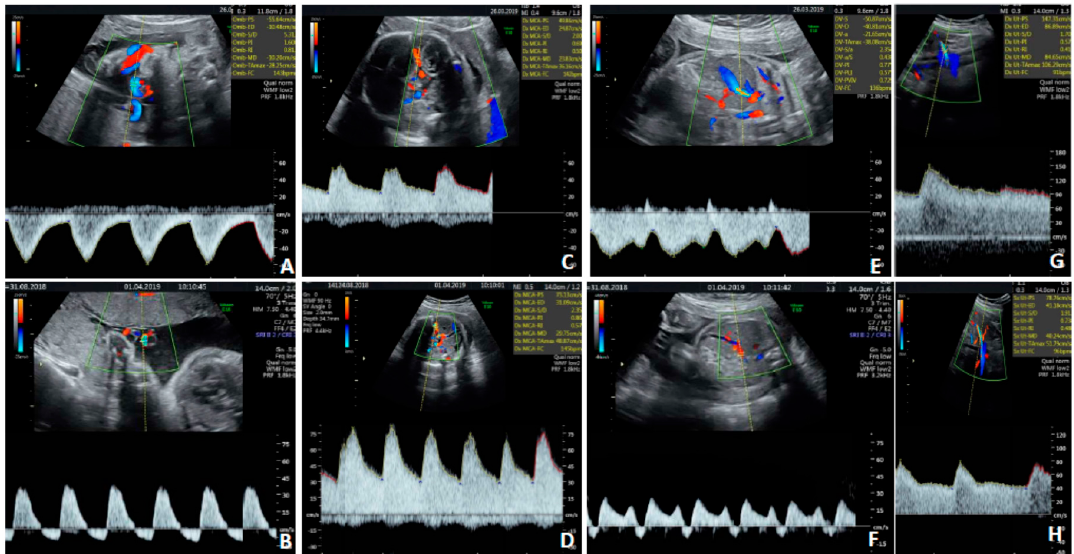
Figure 1. Prenatal Doppler findings for Case 2, showing the rapid progression of fetal Doppler alterations due to CMV infection. Umbilical artery Doppler at diagnosis of fetal growth restriction ( A ) and at delivery 4 days later ( B ). Middle cerebral artery Doppler at diagnosis ( C ) and at delivery ( D ). Ductus venosus Doppler at diagnosis ( E ) and at delivery ( F ). Uterine artery Dopplers were both normal ( G , H ).